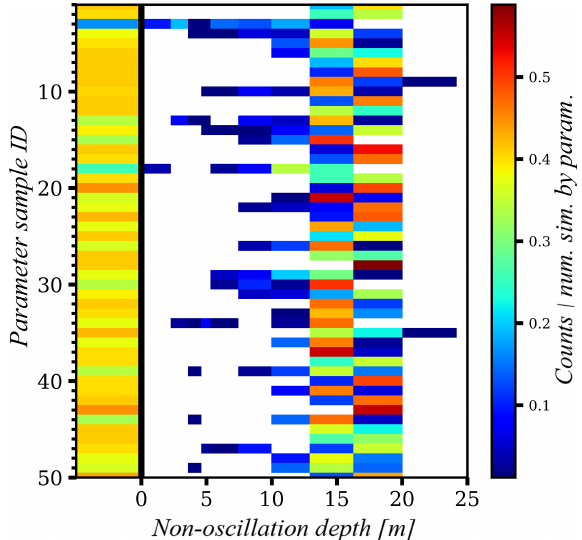
Figure 10. The 2-D histogram of parameter and h T -non-oscillation depth. Counts are normalized by the number of simulations by pa- rameter sample. The thick black line separates the frequency of reaching and not reaching the h T -non-oscillation conditions; bins to the left of this line are for simulations that never reached the h T - non-oscillation